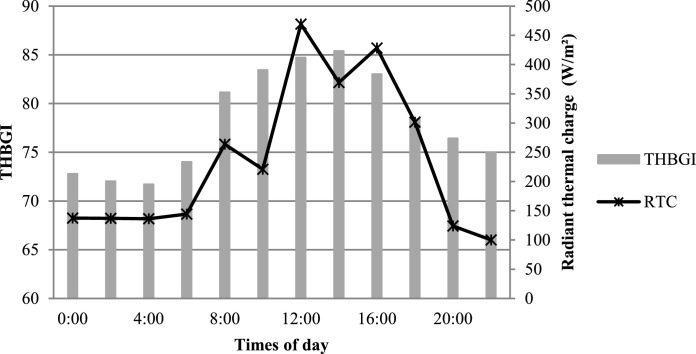
Vermon globe temperature and humidity index (THBGI) measurements and radiant thermal capacity (W/m2).